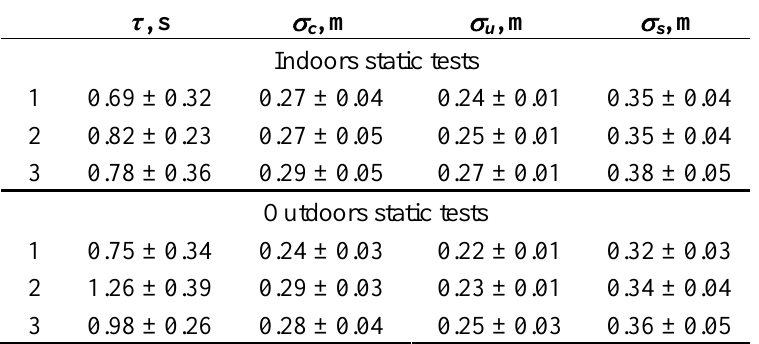
Table 2. ARMA model parameters (10% trimmed mean ± SD)—second